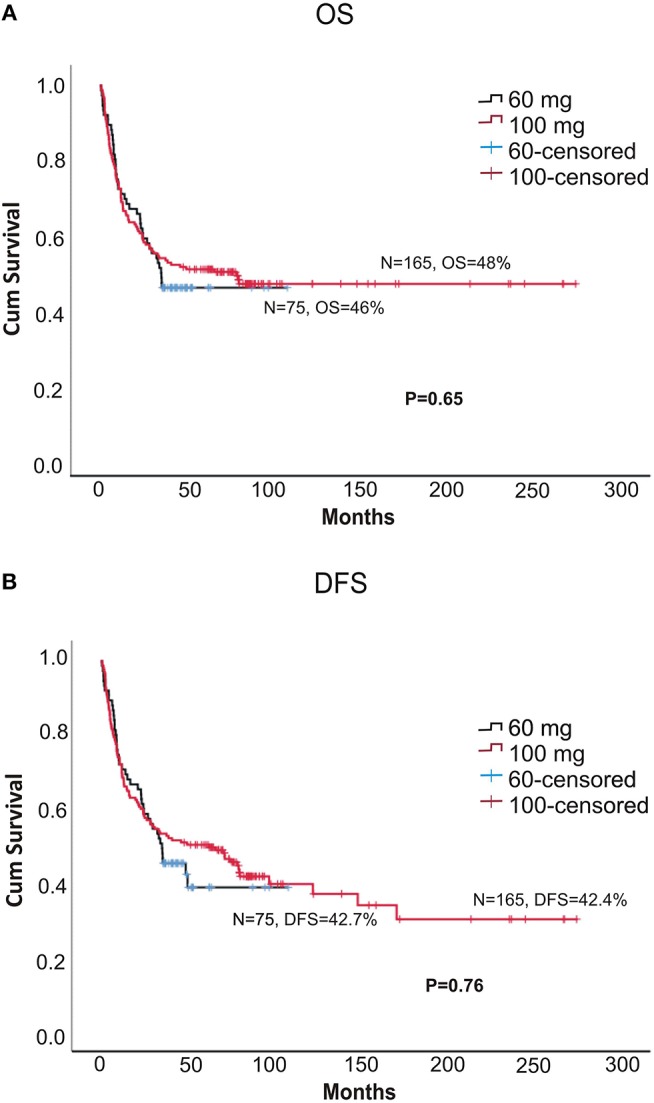
(A,B) The 5-year OS and DFS between different doses of alemtuzumab.